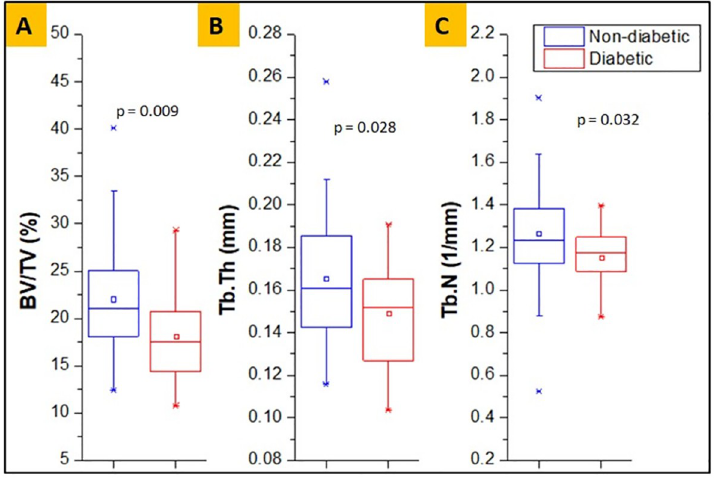
Fig 2. Measures of bone microstructural parameters for diabetic and non-diabetic trabecular bone, showing lower BV/TV (%) (A), Tb.Tb (mm) (B) and Tb.N (1/mm) (C) in diabetic group.